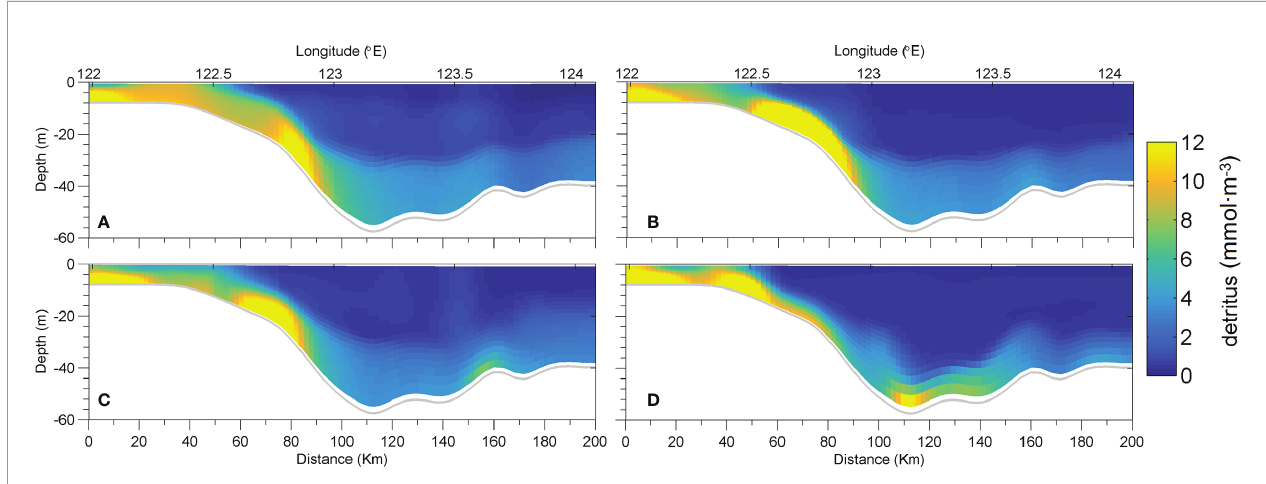
FIGURE 11 | The modeled daily-mean detritus concentrations at the 31°N transect on August (A) 22, (B) 25, (C) 26, and (D) 28,